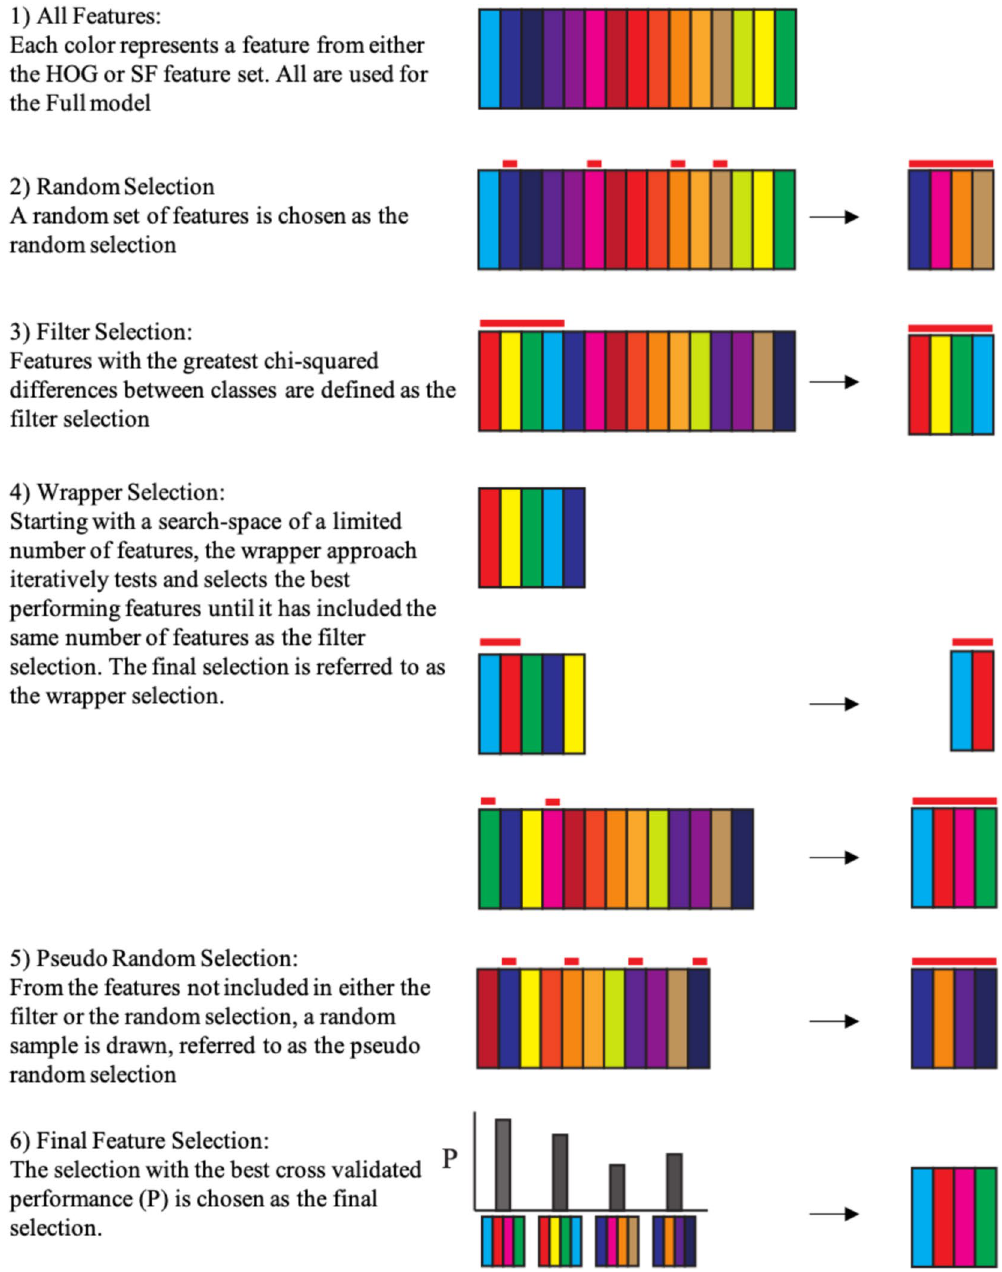
Figure 3. Schematic representation of the feature selection algorithm used in the current project. (1) Visual representation of the feature set. As a comparison to feature selection performance, all of the available features will be used to train and test a model referred to as the Full model. (2) A random collection of features (indicated by the red bars) is selected for a random selection. (3) The features are ranked based on Chi-Square scores. The top of the ranking is used to determine the filter model. (4) A search space is defined from the top- ranking features and the features in this search space are tested for inclusion into the wrapper selection through an iterative process until enough features have been selected for the wrapper model. (5) From the residual features, unused by the wrapper or filter selections, a random selection is made for a pseudo random selection. (6) Each of the four combinations of features are used to train classification models and cross-validation performance is subsequently estimated using the hold-out data. The final selection is based on highest cross- validation performance (P). See the above section Feature Inclusion, and the below section final feature selection for additional